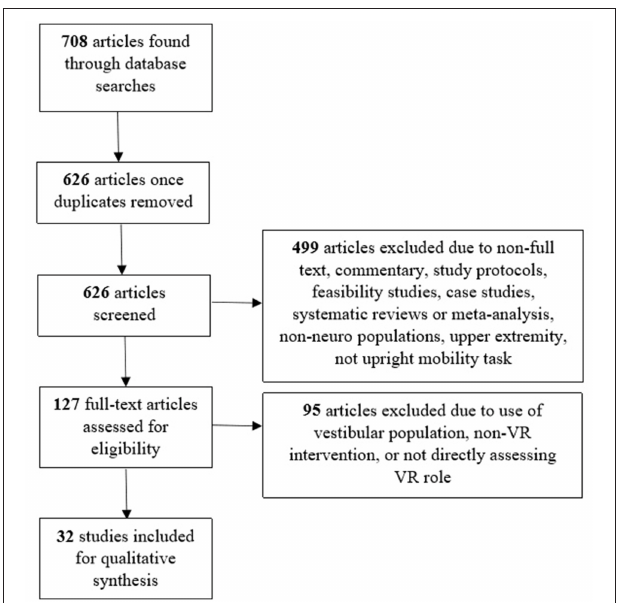
FIGURE 2 | Flowchart of systematic article search and inclusion for